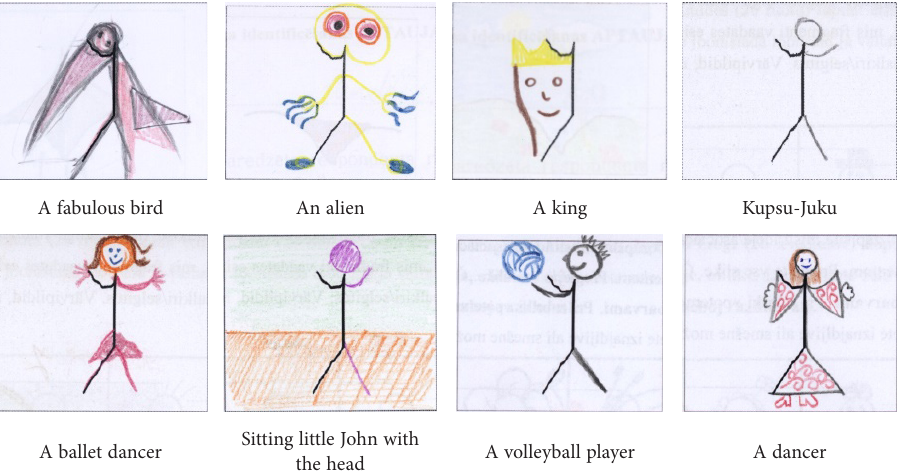
Figure 32. The creative task: interpretation of Fragment 5 – a character (source: testingmom.com,